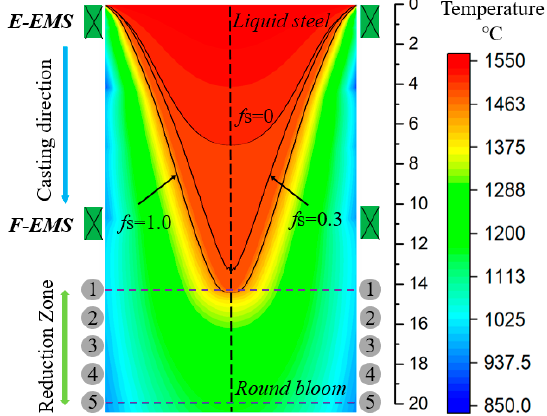
Figure 6. Temperature distribution on longitudinal section of round bloom.